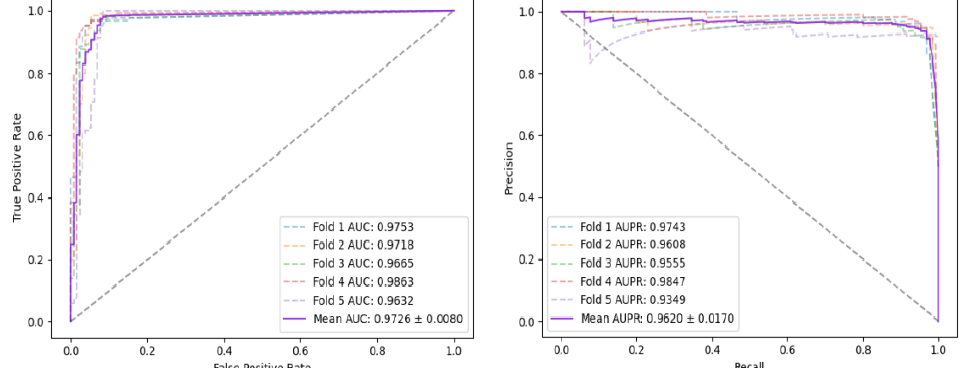
Figure 3. AUC and AUPR curves of FFCV obtained by GGCDA on CircR2Disease. Table 2. Results of FFCV on CircR2Disease achieved by GGCDA.